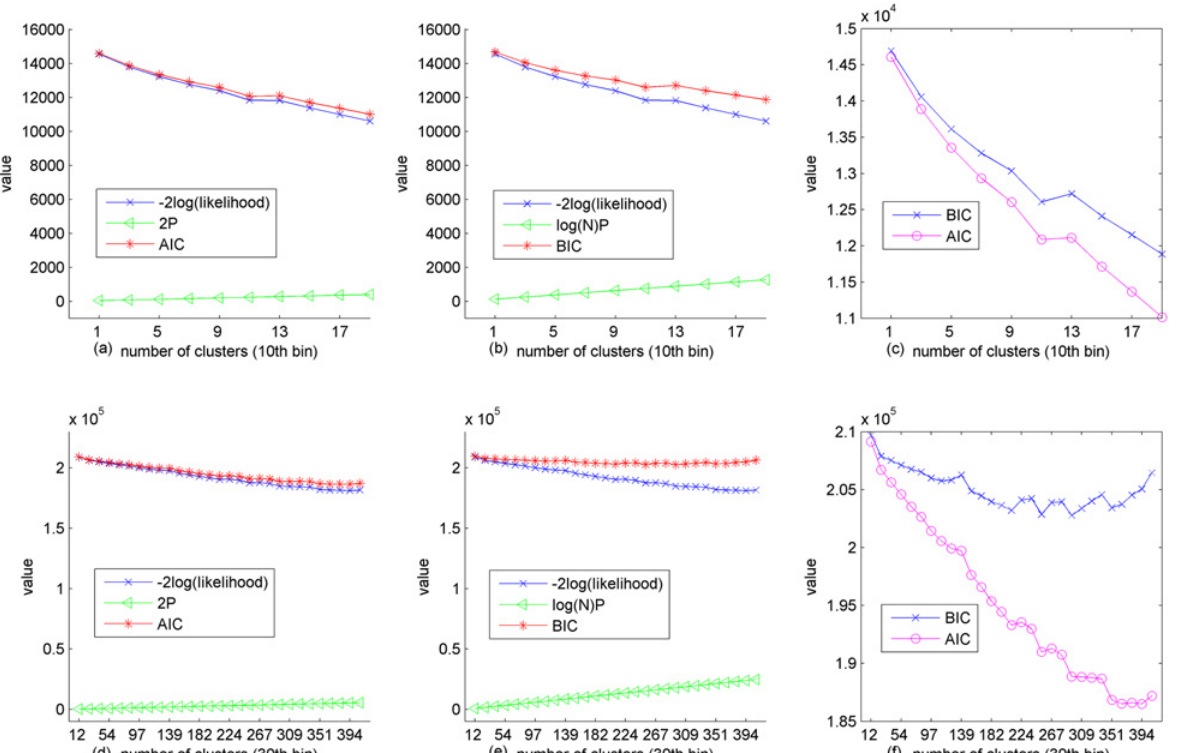
Fig 1. BIC and AIC score displayed for the 10 th (top) and 30 th (bottom) bin in 50 bin. Results are obtained by using pSMC normalization of the ADNI dataset. The AIC (red) and BIC (red) values are simply -2log(likelihood) (blue) plus 2 P (green) and log( N ) P (green), respectively. Refer to Eq 7 and Eq 8 for the definition of AIC and BIC. (a), (b) (d) and (f) show the AIC and BIC along with their components' value. (c) and (f) offers a direct comparison between AIC and BIC. The 10 th bin contains 586 voxels, hence it is a small sample, in contrast to the large sample of the 30 th bin containing 12,414 voxels. Note that the term “ sample ” in this context does not mean the number of patients, but the number of voxels to be clustered.